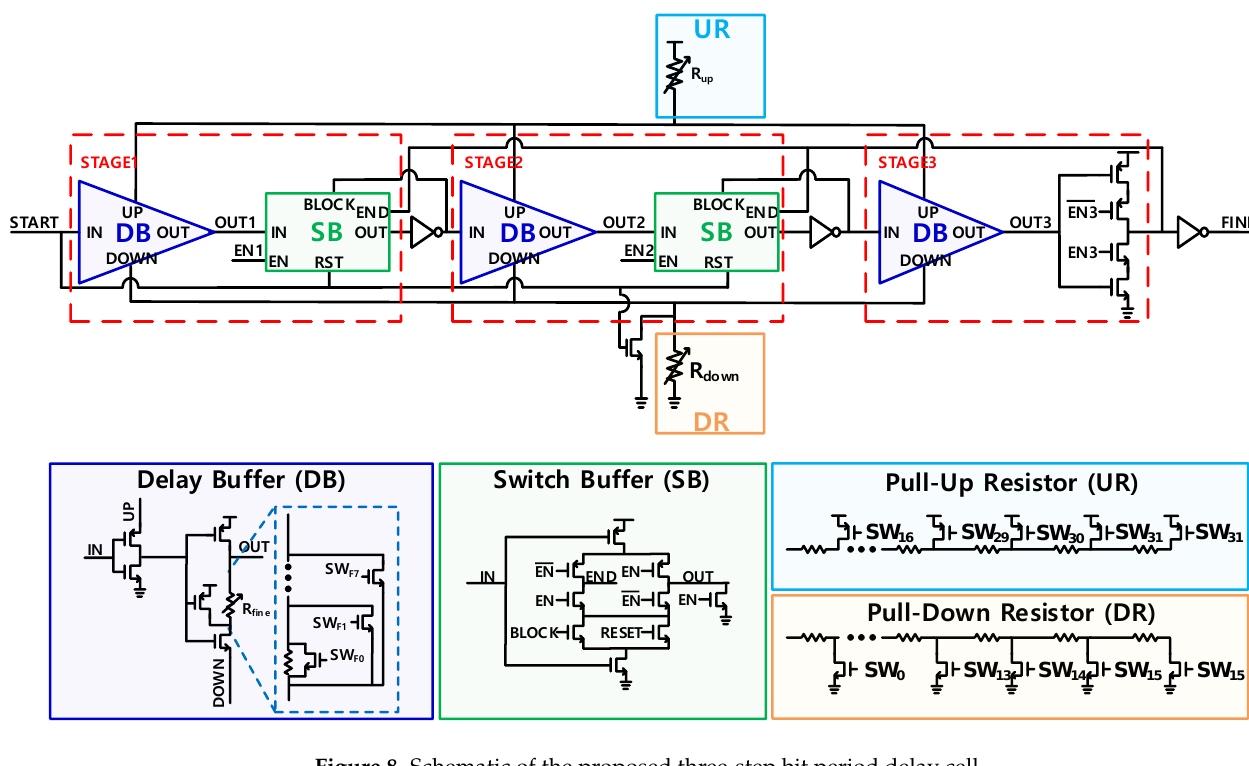
Figure 8. Schematic of the proposed three-step bit period delay cell.